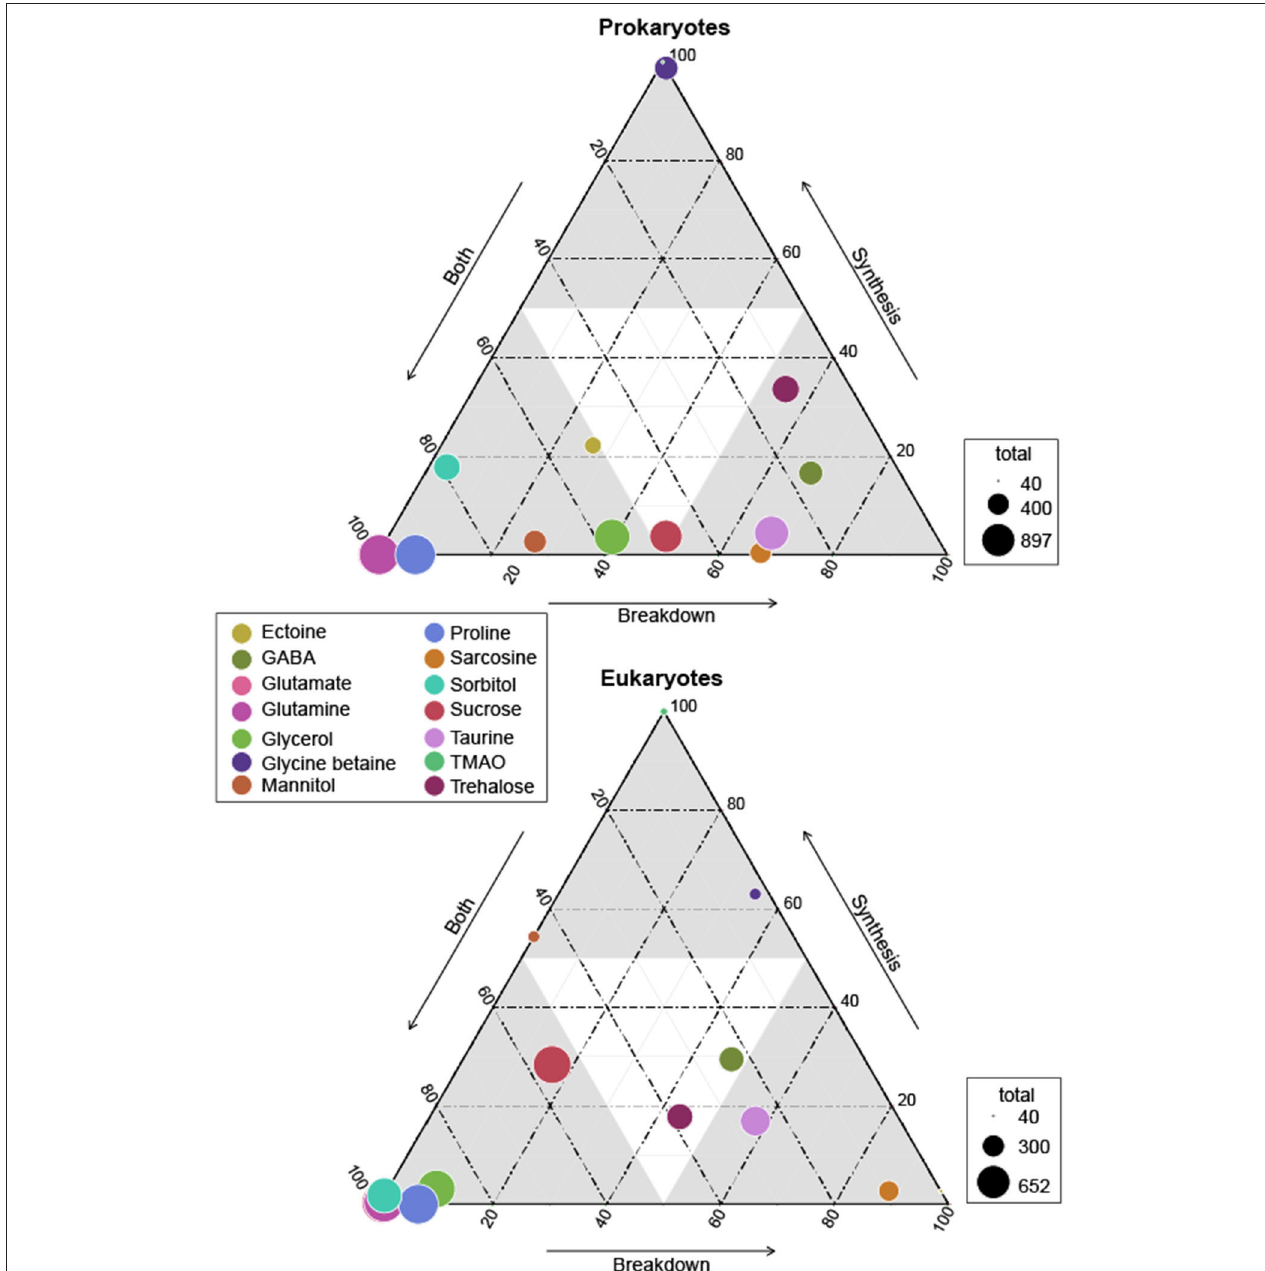
FIGURE 1 | Ternary plot of prokaryotes and eukaryotes osmolyte utilization based on genomic potential. Circle size represents total prokaryotes or eukaryotes capable of synthesis and/or breakdown of an osmolyte and circle placement represents the proportion of the total capable of synthesis, breakdown, or both synthesis and breakdown. Circle sizes are scaled by the total number of MarRef genomes ( n = 897) and MMETSP transcriptomes ( n = 652) surveyed. Osmolytes are designated by color as depicted in the legend. Glutamate is not clearly visible as it is found directly behind glutamine for both prokaryotes and eukaryotes.